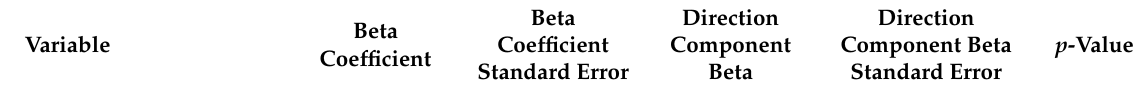
Table 4. Impact of demographic, clinical, angiographic, biochemical and electrocardiographic variables on increase in LVEDV 6 months after STEMI in multiple linear regression models. Models 1–3 were obtained by adding a single electrocardiographic variable to the demographic, clinical and angiographic data shown in Table 1. In the subsequently built Model 4, we included all electrocardiographic variables. Finally, we added biochemical data presented in Table 1 to previously analyzed demographic, clinical, angiographic and electrocardiographic variables (Model